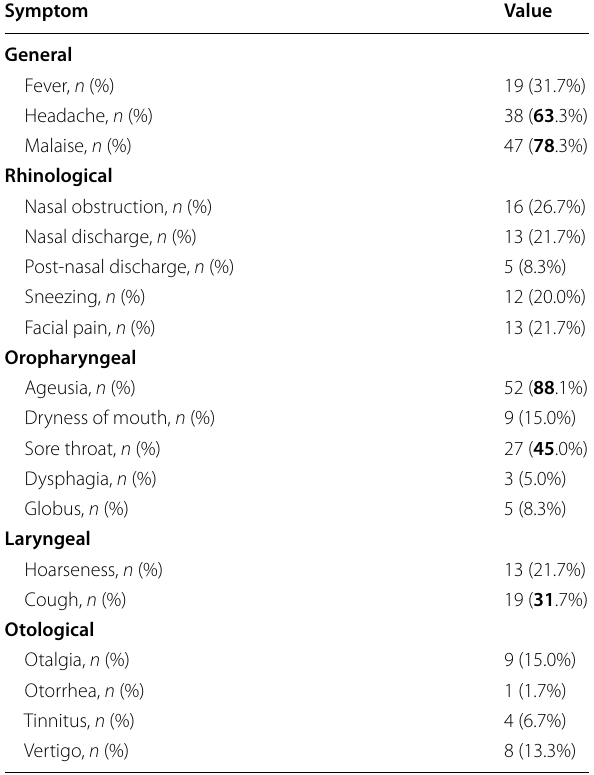
Table 1 Prevalence of associated symptoms in the study